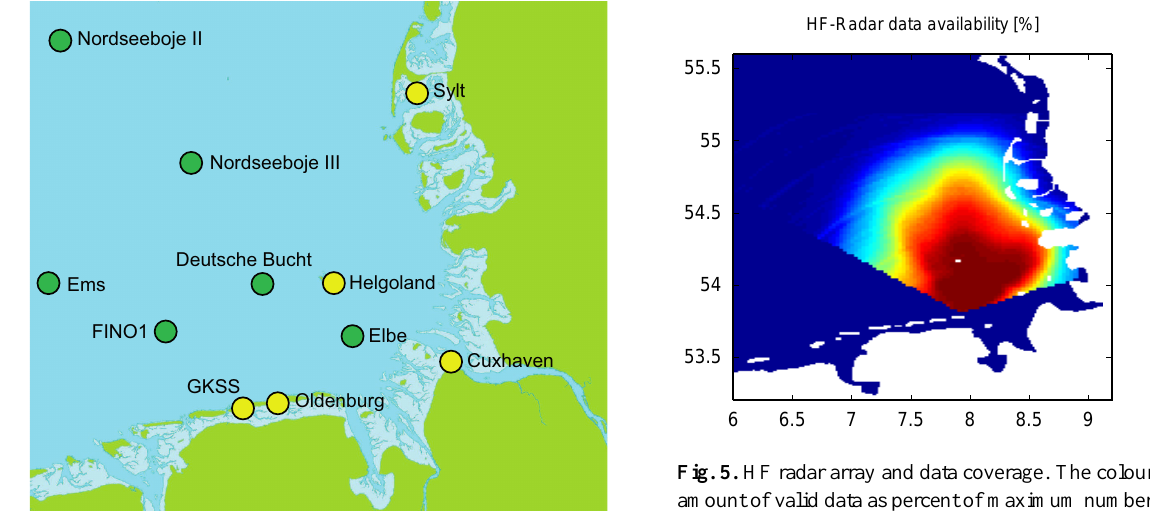
F IG . 4. Fixed stations in the German Bight. Green circles-locations of MARNET stations, yellow circles - coastal stations.